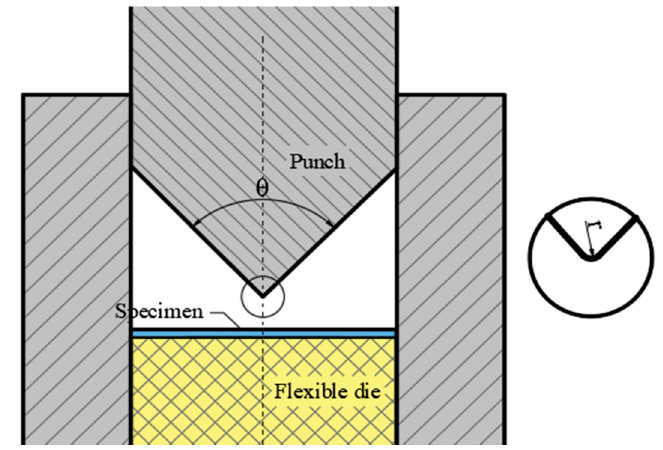
Figure 4. Diagram of V-bending process.